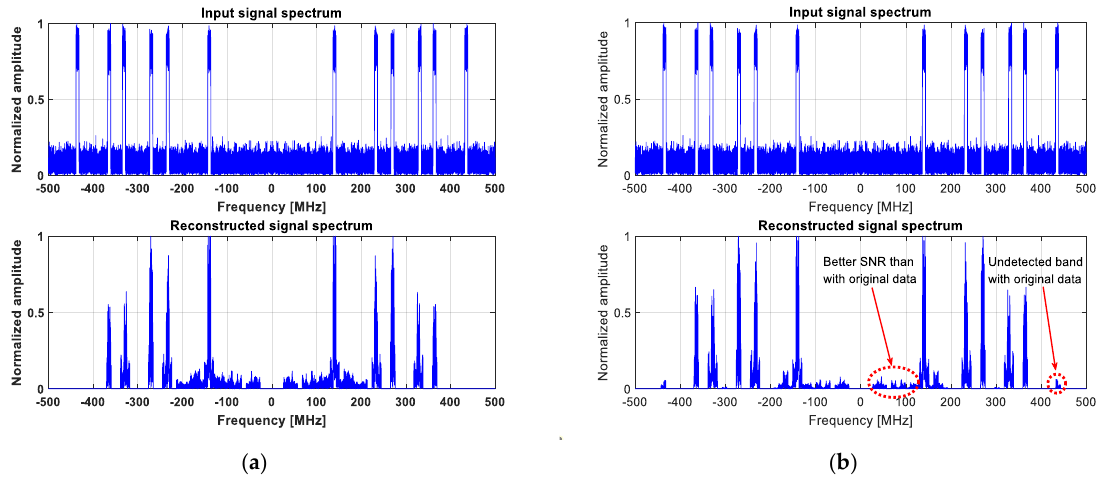
Figure 13. Wideband spectrum sensing results provided by the proposed reconstruction algorithm for six active transmitters: ( a ) Original measured data; ( b ) Reduced data.